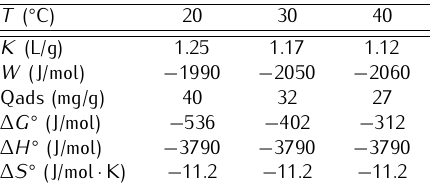
Table 3. Parameters of Fowler-Guggenheim model and Thermodynamic parameters of phenol over HBEA zeolite at different temperature.